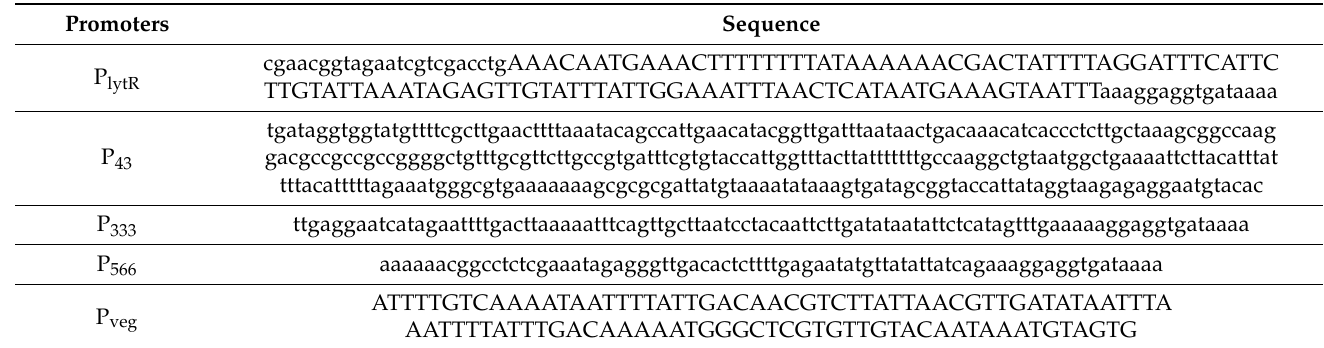
Table 2. Sequences of the promoters used in this